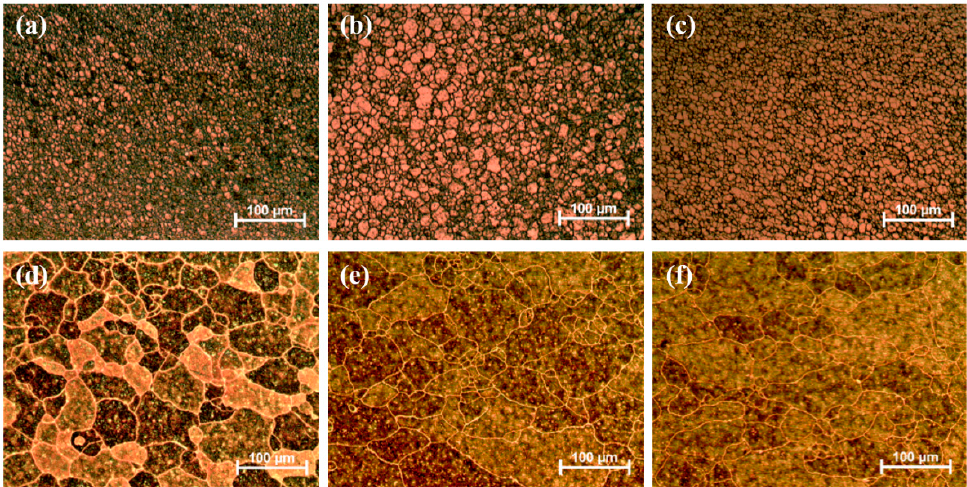
Figure 10. Microstructure of top ( a ), middle ( b ), and bottom ( c ) of the NZ zone, base material ( d ), the HAZ area far from the weld region ( e ), and the HAZ area near the NZ ( f ) for the RAFSW joint aged artificially at 220 °C for 30 min.